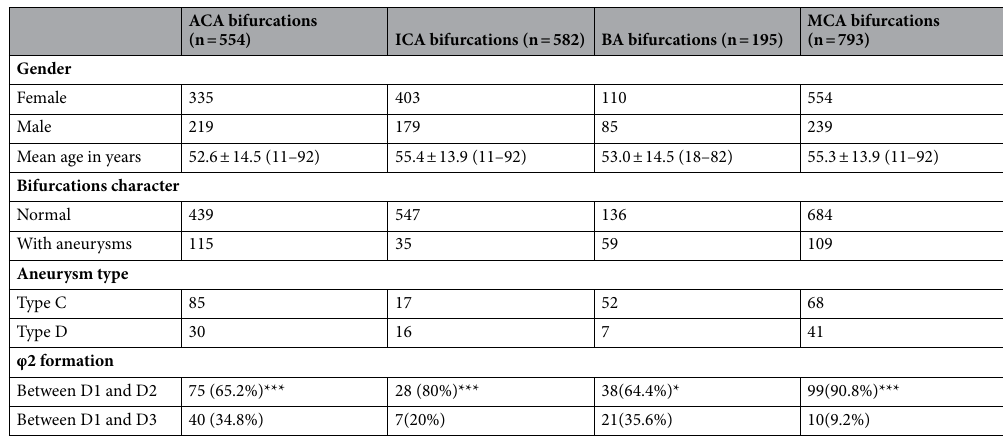
Table 1. Baseline characteristics of patients. Data are shown as mean ± standard deviation. ACA anterior cerebral artery, ICA internal carotid artery, BA basilar artery, MCA middle cerebral artery. Type C, the parent vessel centerline crosses the aneurysm neck, and type D, the parent vessel centerline does not cross the aneurysm neck. D1, D2 and D3 indicate the diameter of the parent vessel, smaller and larger daughter branch, respectively. * P < 0.05 and *** P < 0.001 indicate significant differences of angle φ2 formed between D1 and D2, D1 and D3,